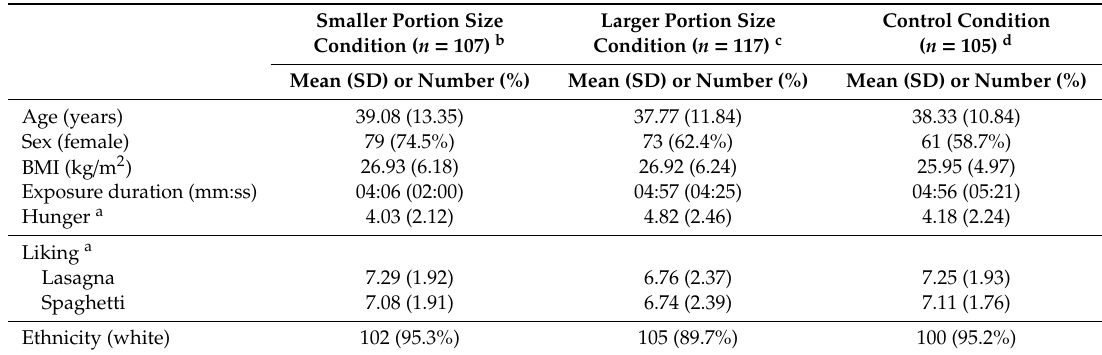
Table 2. Participant characteristics per condition ( n =